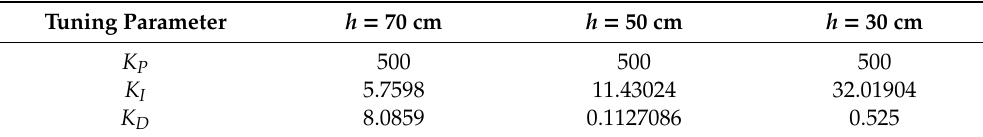
Table 10. Performance comparison of RTD-A and PID for the conical tank.